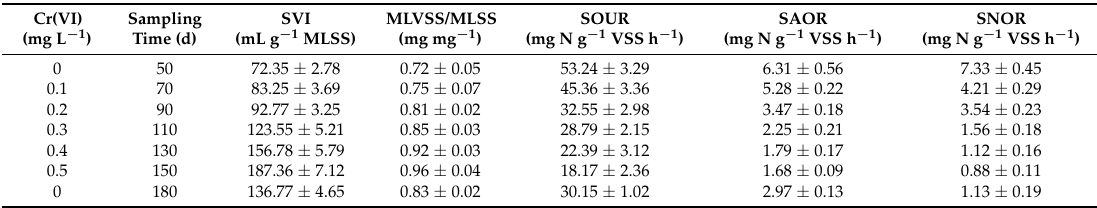
Table 1. Characteristics of nitrifying activated sludge at different influent Cr(VI)